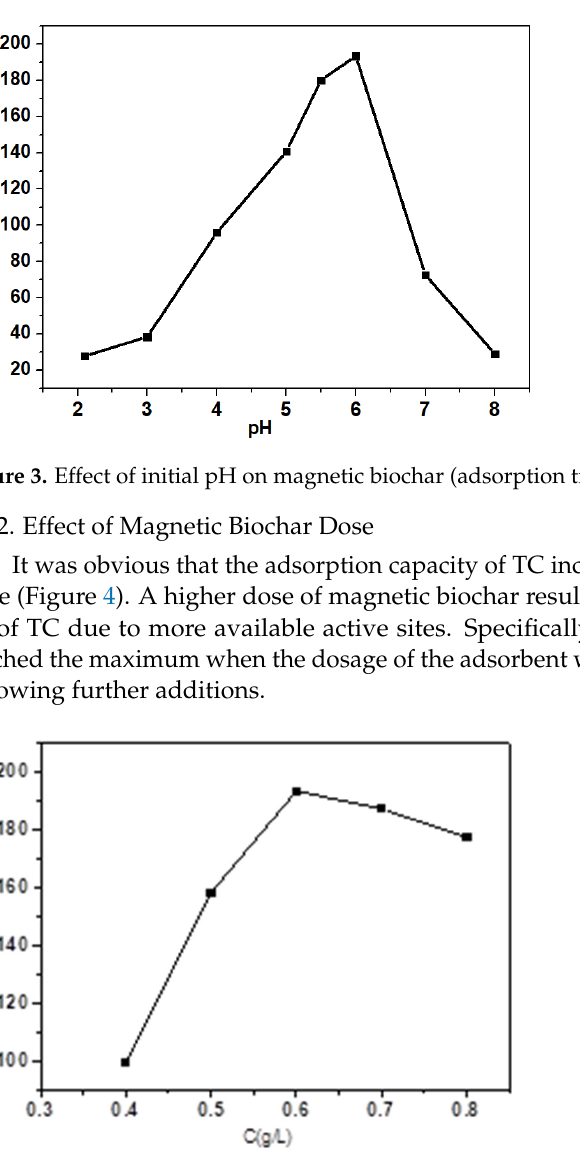
Figure 4. Effect of magnetic biochar dose (adsorption time: 18 h).